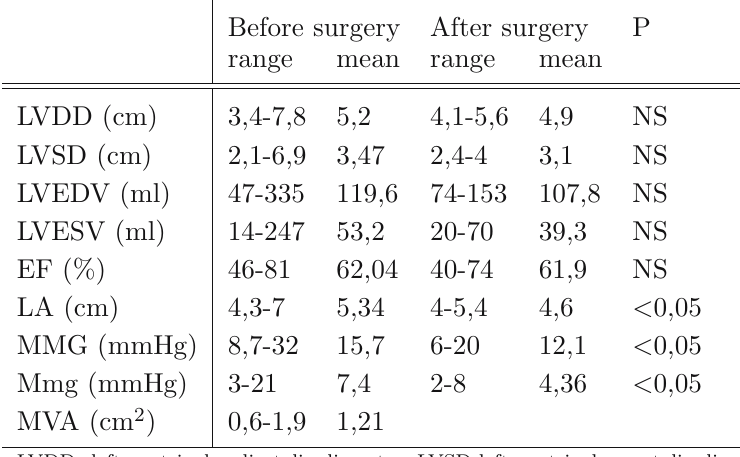
Table 3 Preoperative and follow- up echocardiographic data.